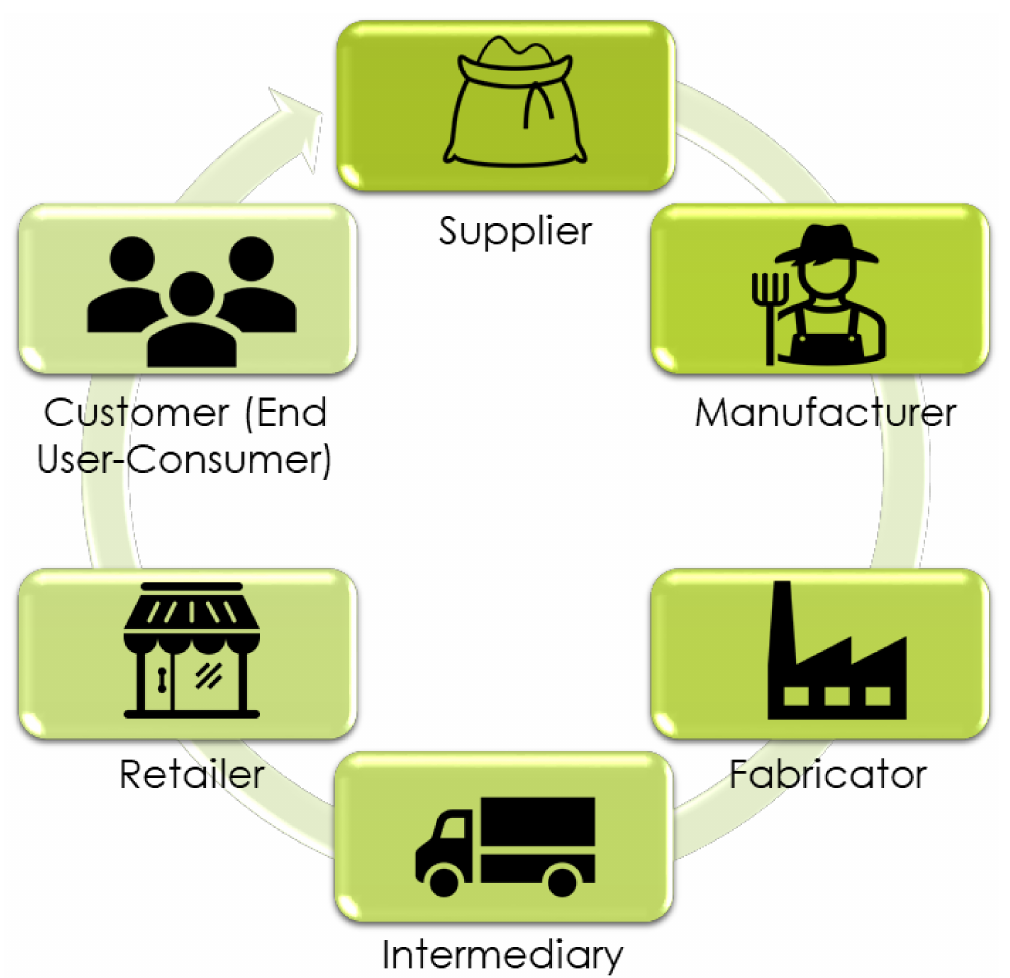
Figure 2. Agri-food product supply